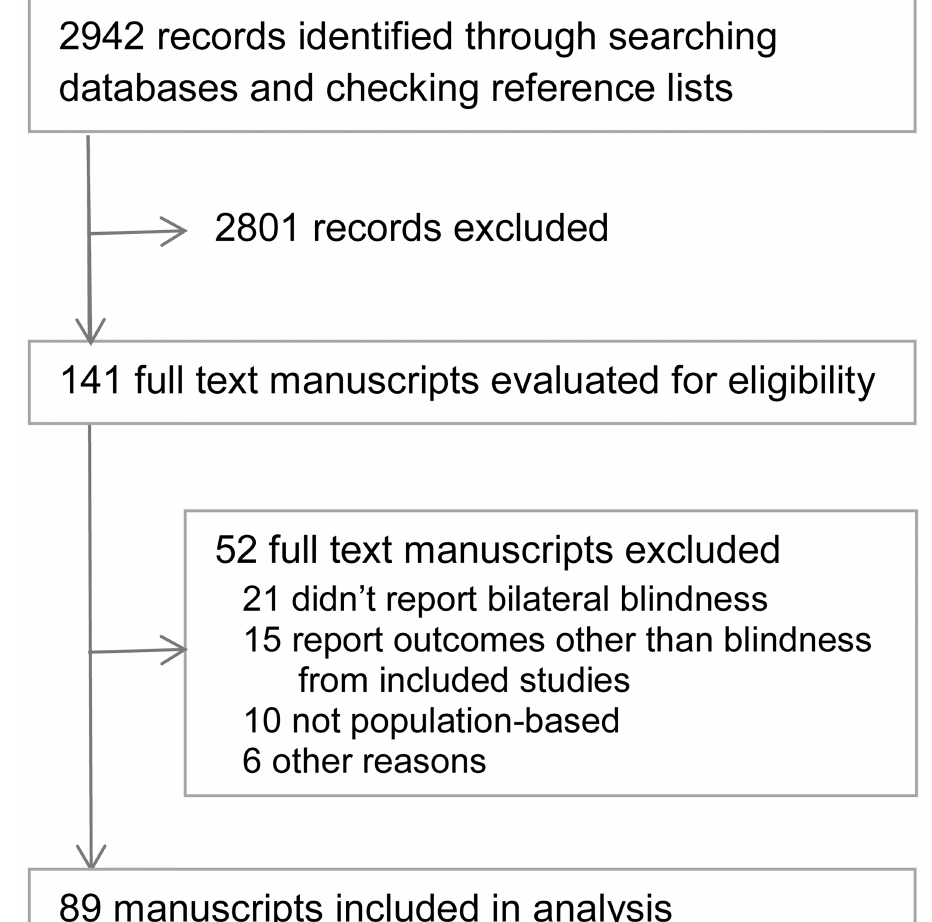
Fig 1. Summary of study search and